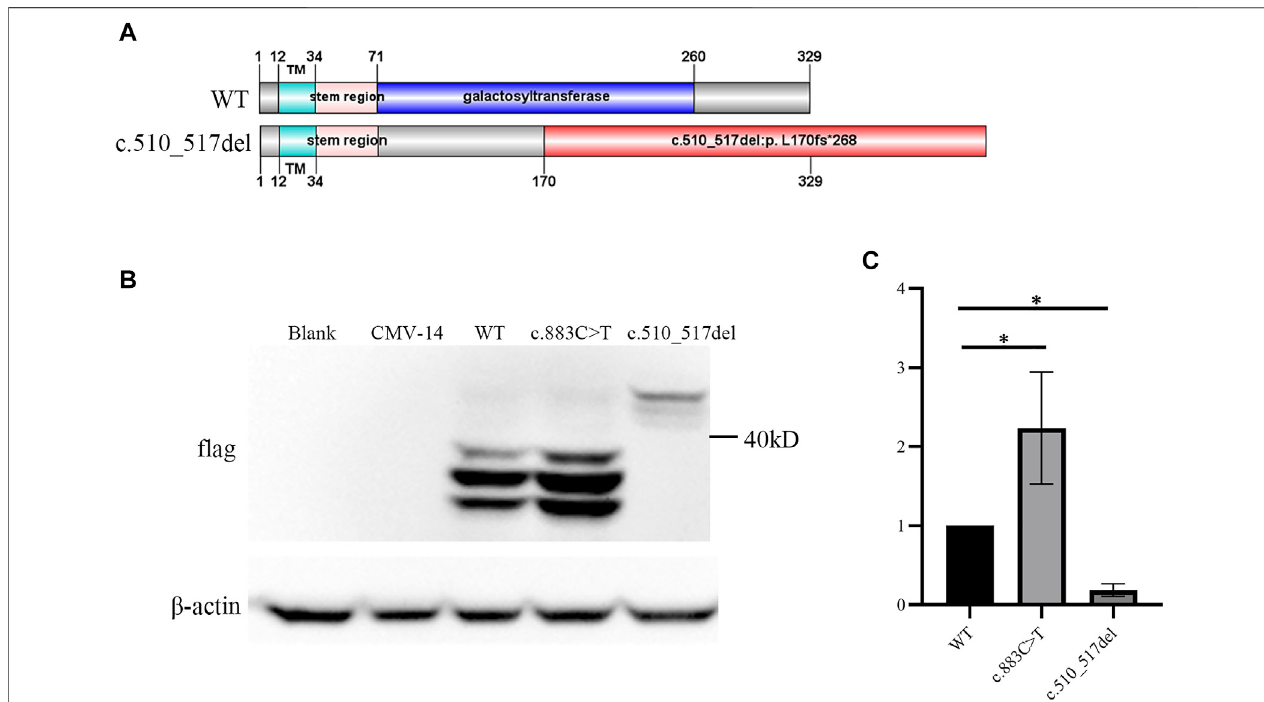
FIGURE 2 | c.510_517del:p. L170fs*268 linked an elongated product. (A) Upper panel represents the wild-type (WT) β 3Galt6. Lower panel represents the c.510_517del:p. L170fs*268 elongation variant. Note: in wild-type β 3Galt6, the catalytic galactosyltransferase domain was depicted in blue; red: frameshift amino acid sequence caused by the deletion. (B) Western blot analysis of lysates from HeLa cells expressing WT and mutant B3GALT6. CMV-14, empty plasmid. (C) Relative density of β 3Galt6. n = 4 per group, * p < 0.05.